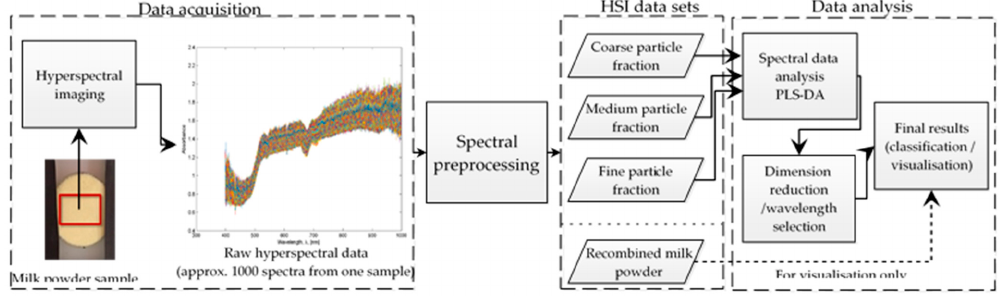
Figure 1. Flowchart of the key steps involved in hyperspectral imaging analysis.